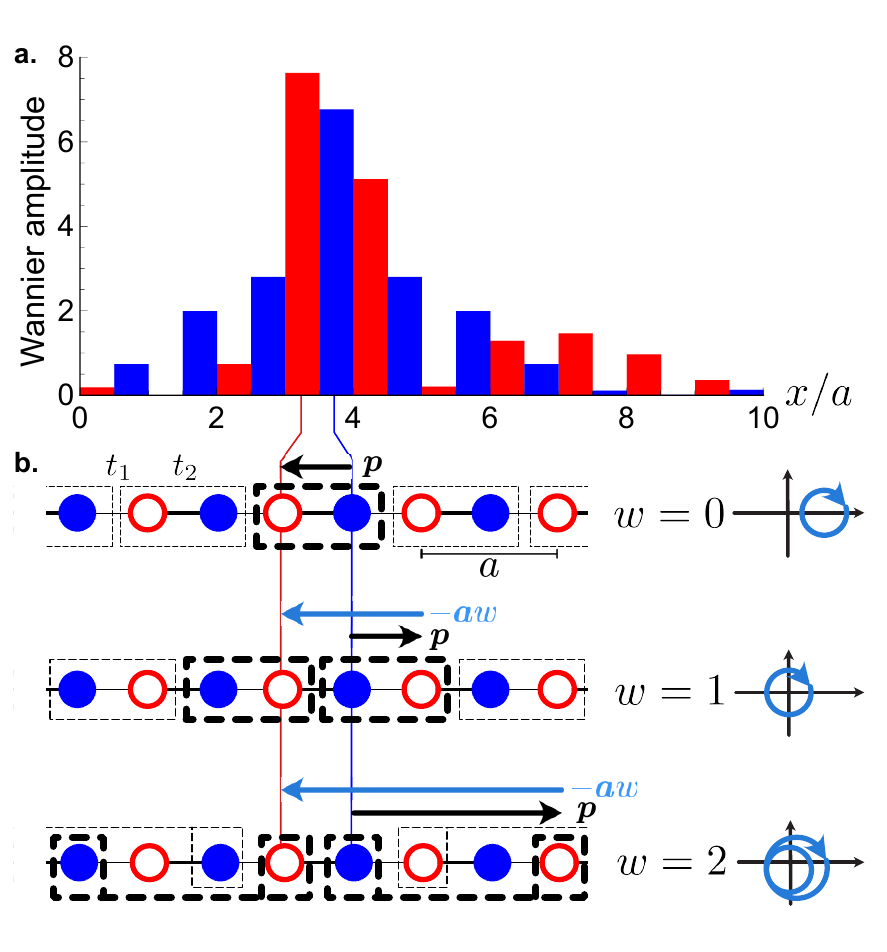
Figure 2: Chiral polarization and Wannier functions. a. Square of the Wannier amplitude projected into the A (red) and B (blue) sublattices for the ground state configuration of the two-band SSH model with hopping ratio t the period of the 1D frame. The chiral polarization Π = chain is left polarized regardless of the choice of unit cell. b. The winding number of the Bloch Hamiltonian encodes the chiral polarization relative to a given unit cell. The chiral polarization being a material property, the winding number w can therefore take any integer value when redefining the geometry of the unit cell as illustrated in the last column. Whatever the choice of the unit cell, the difference between the geometrical polarization and aw has a constant value given by the chiral polarization Π